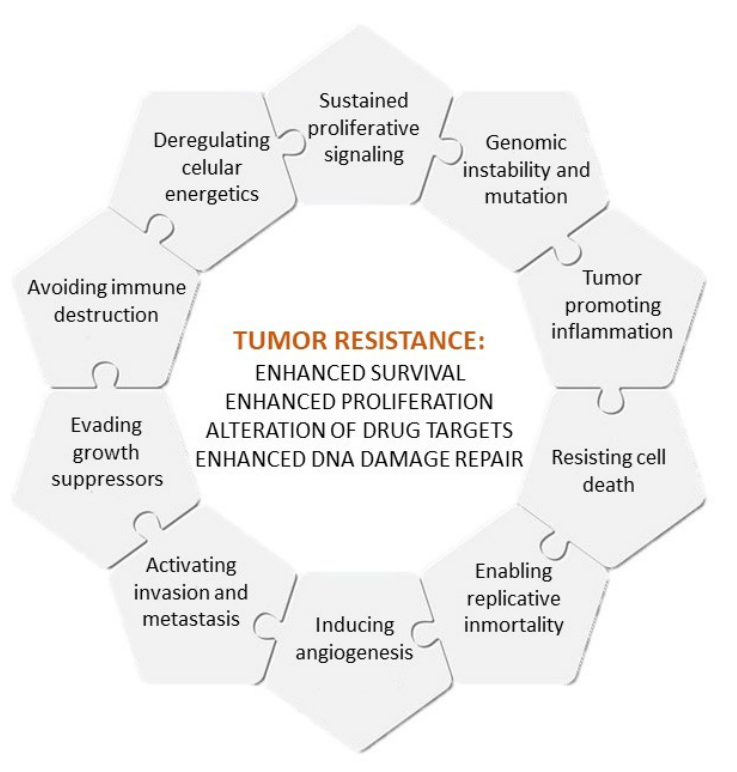
Figure 1. Hallmarks of cancer and causes of multidrug resistance.